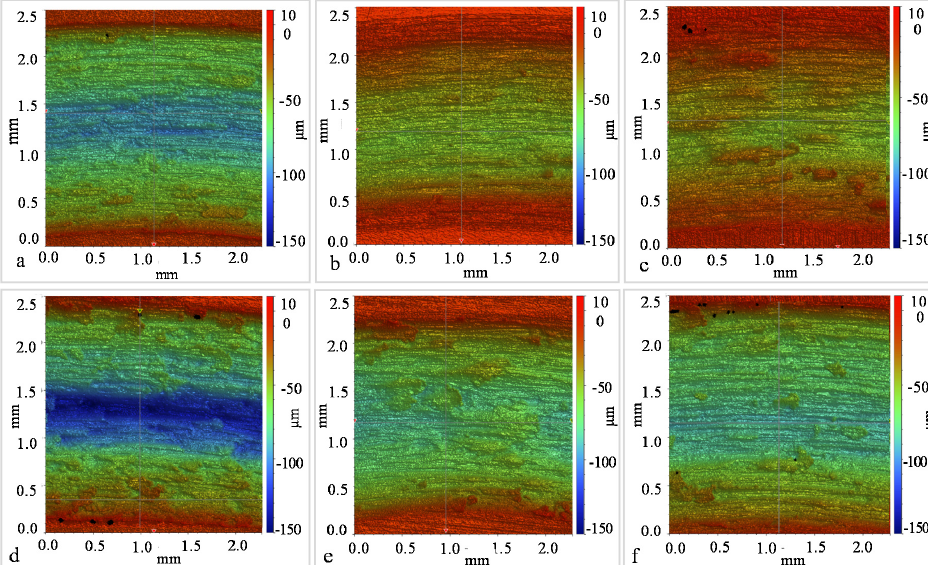
Figure 9. Surface roughness maps of the wear tracks for Monel K500 in ( a ) as-weld, ( b ) annealed and aged at 610 °C and ( c ) annealed and aged at 610 °C + 480 °C conditions and for FM60 in ( d ) as-weld, ( e ) annealed and aged at 610 ◦ C and ( f ) annealed and aged at 610 ◦ C + 480 ◦ C conditions (travel speed ( e ) annealed and aged at 610 °C and ( f ) annealed and aged at 610 °C + 480 °C conditions (travel speed of 500 mm/min). of 500